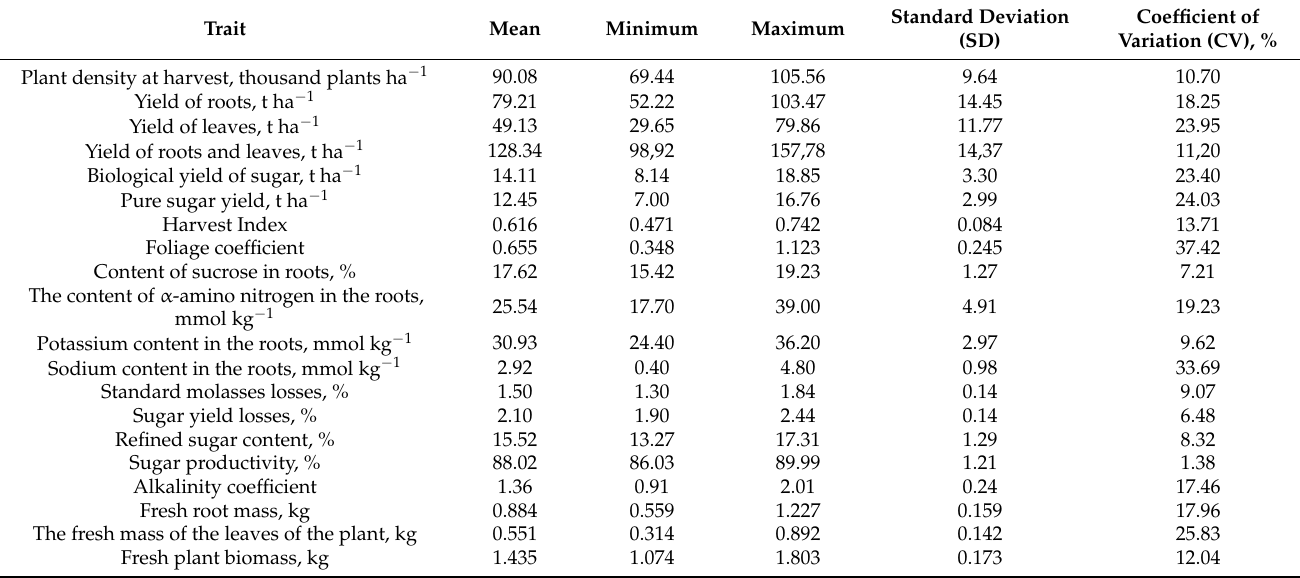
Table 5. Descriptive statistics for all experiments with sugar beet